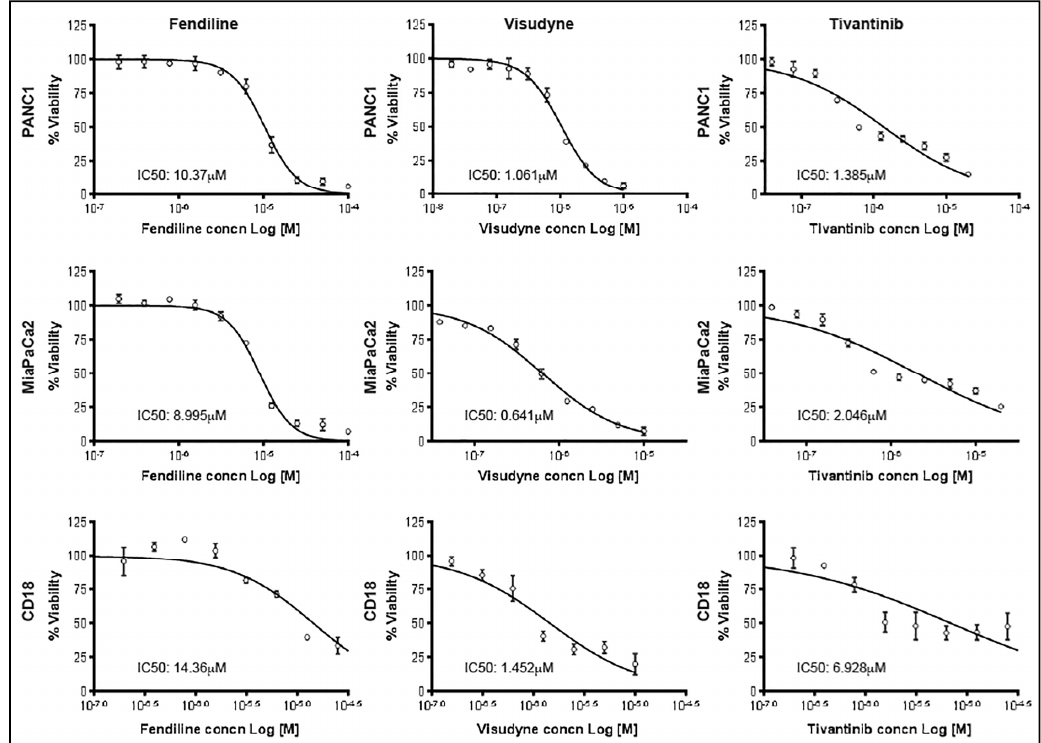
Figure 2. IC50 determination in PDAC cells: PDAC cells treated with incremental concentrations of fendiline, visudyne or tivantinib and viability was determined by MTT assay after 48 h. IC 50 values were determined using GraphPad Prism 6 software.